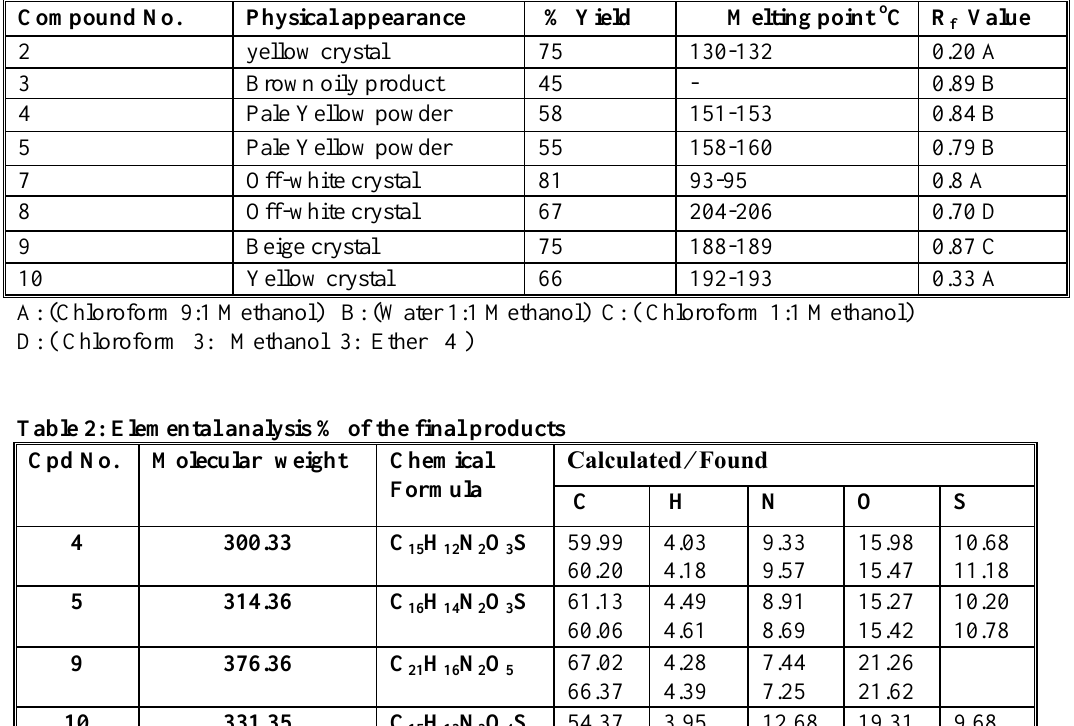
values of intermediates f